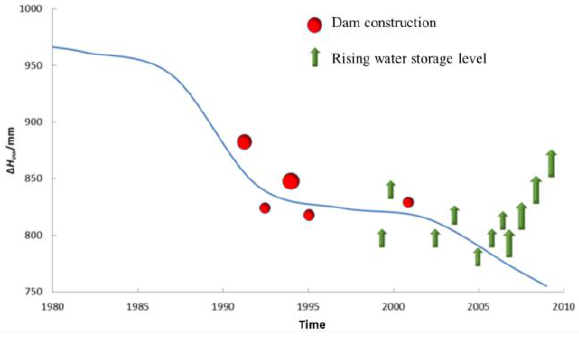
Figure 7. Important large water conservancy events along secondary lakes and rivers.